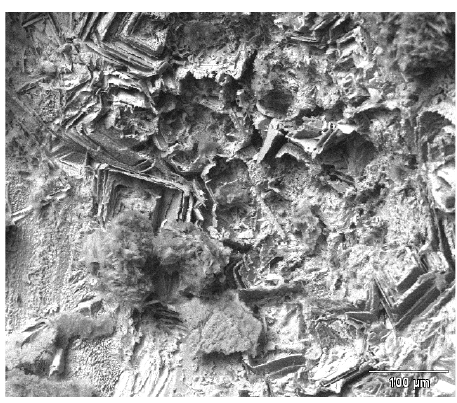
Figure 15. The copper crystallographic surfaces inside a pit (not fixed in HMDS).